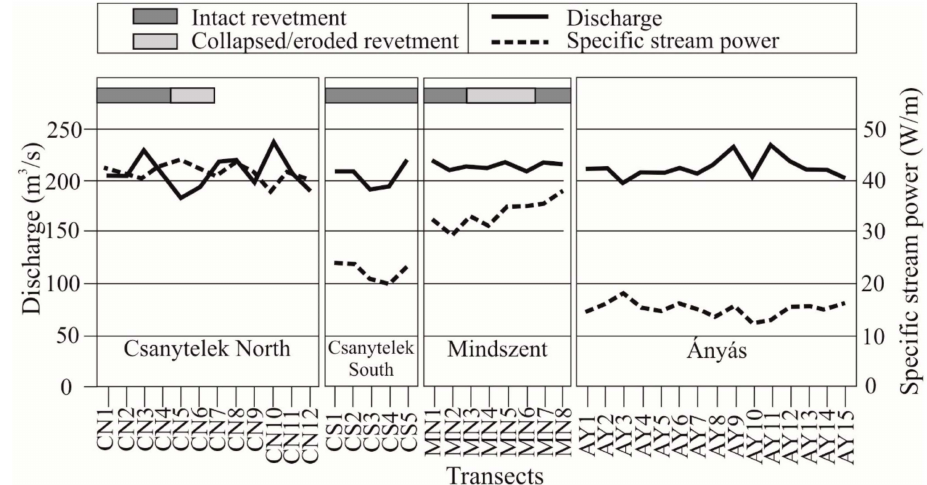
Figure 10. Variation of specific stream power and discharge values along the studied sections showing locations of revetments on the right